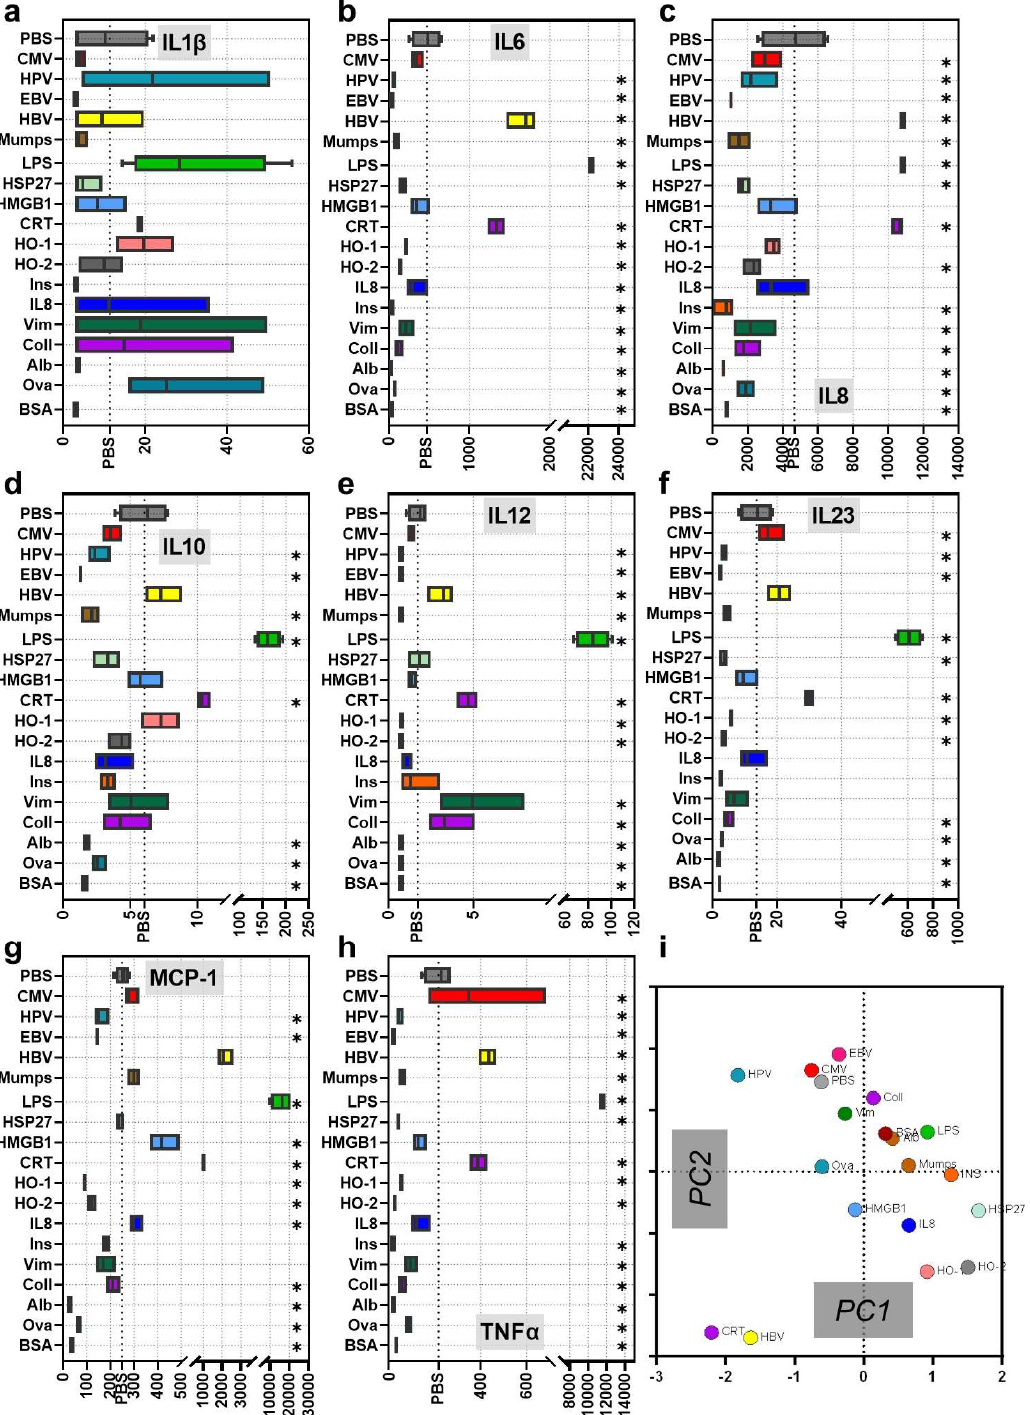
Figure 2. Secretion profiles of monocyte-derived cells incubated with different proteins . ( a – h ) supernatants of stimulated monocyte-derived cells were analyzed for pro-inflammatory and anti-in- flammatory cytokines (in pg/mL) using a multiplex assay: IL1β ( a ), IL6 ( b ), IL8 ( c ), IL10 ( d ), IL12 ( e ), IL23 ( f ), MCP-1 ( g ), and TNFα ( h ); ( i ) principal component analysis of surface marker and secretion